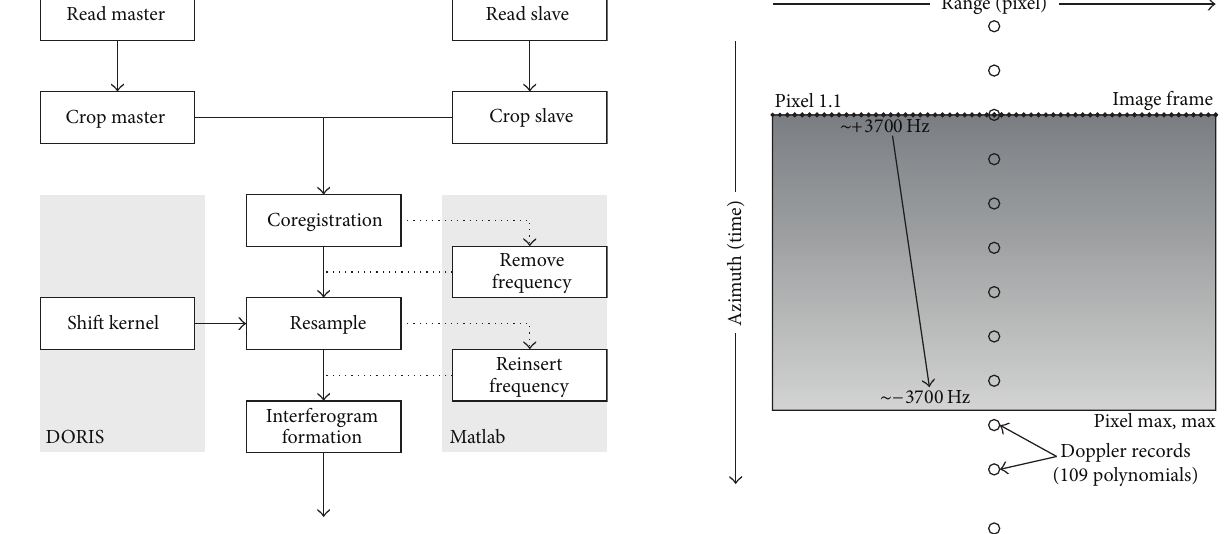
Figure 7: Schematic sketch of interpolation values derived from XML data. The x -axis represents the range time calculated from the pixel number, and the y -axis is interpolated from the annotated Doppler polynomial records. The recording of them starts and ends before and after the actual image